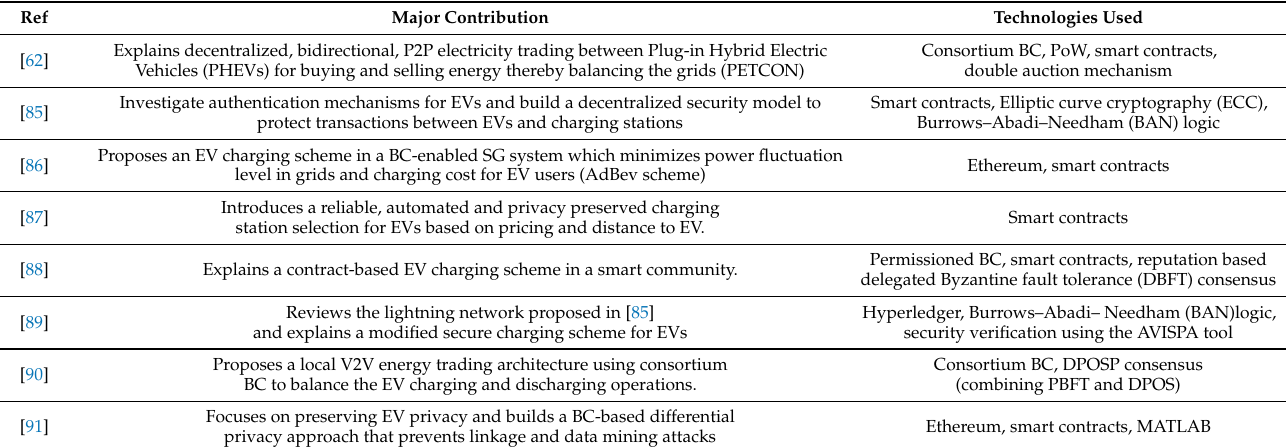
Table 6. Summary of existing works related to electric vehicles using